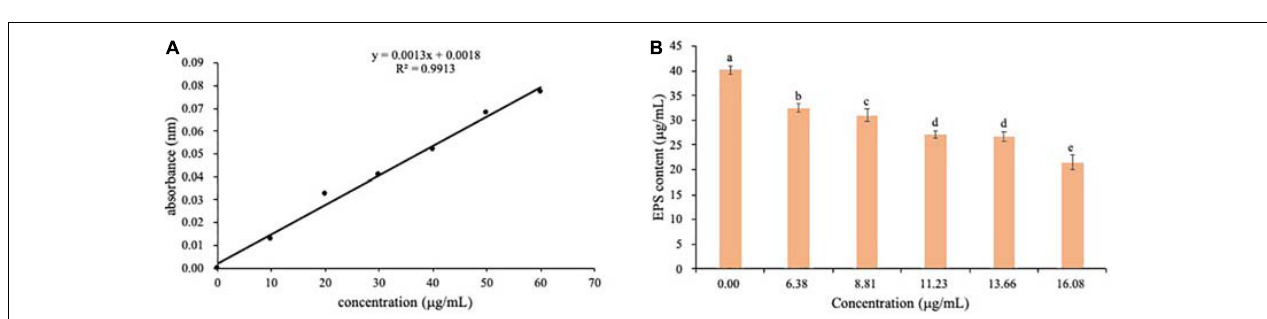
FIGURE 10 | The determination of EPS content of Ps. camelliae-sinensis strain GZHS-2017-010 hyphae treated with phenazine-1-carboxylic acid (PCA). (A) Standard curve for determination of EPS content. (B) Effect of various dosages of PCA on EPS content of Ps. camelliae-sinensis strain GZHS-2017-010 hyphae.